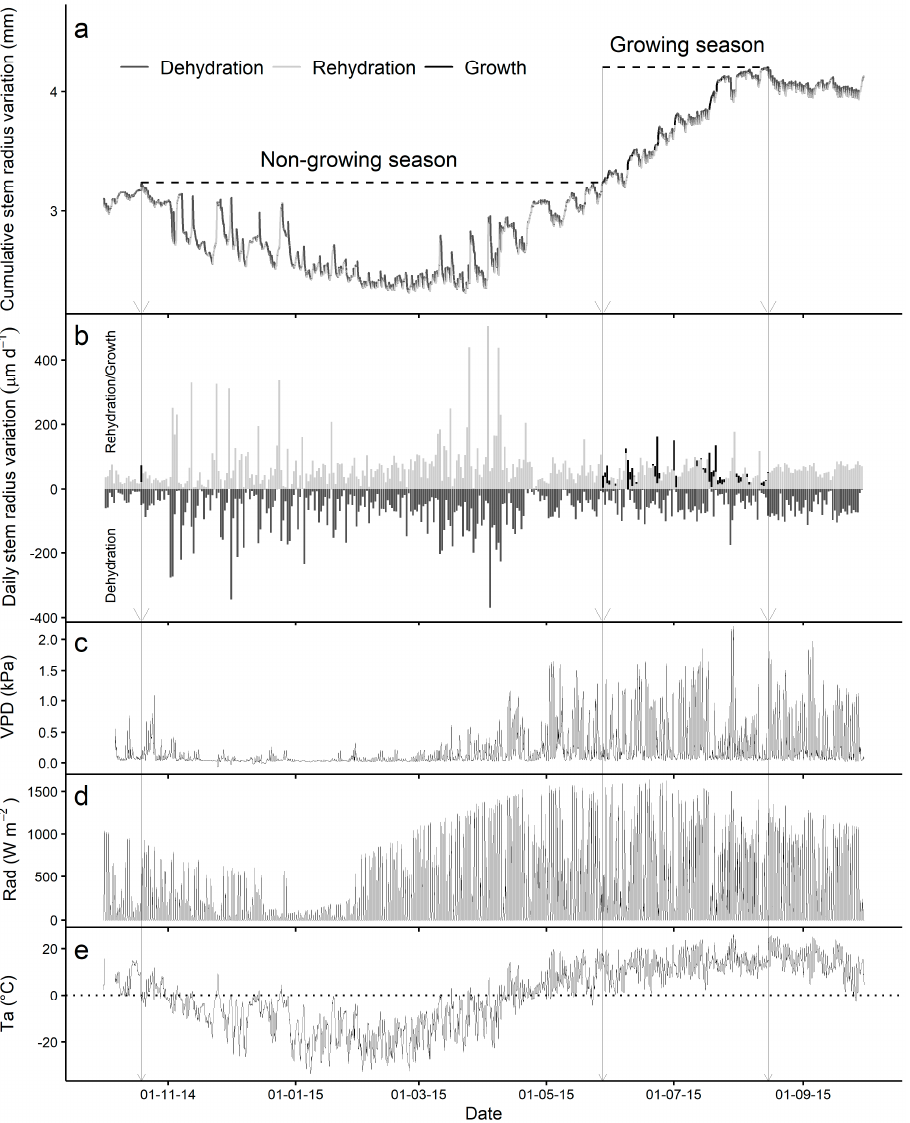
Figure 1. ( a ) Annual pattern of cumulative stem radius variation with 15 min intervals (mm) and ( b ) daily stem radius variation (µm day − 1 ) associated with growth and tree water status variations (dehydration and rehydration) for Tree 104 in 2014–2015, and ( c ) mean daily vapour pressure deficit (VPD), ( d ) solar radiation (Rad), and ( e ) air temperature (Ta) over the same period.